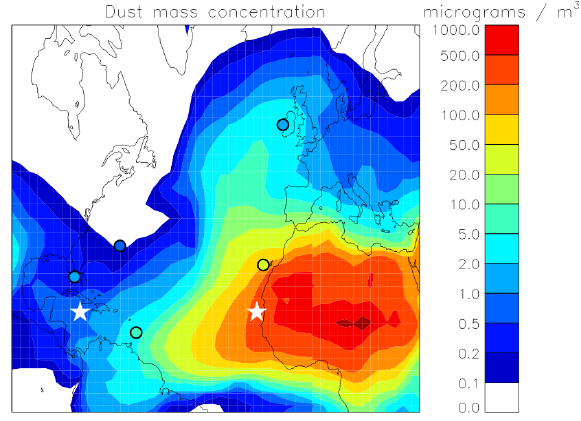
Fig. 4 Three-month mean (January-March) surface dust mass concentrations from Fig. 4. Three-month mean (January–March) surface dust mass con- the region of interest from GLOMAP-bin, overlaid with equivalent in-situ observations centrations from the region of interest from GLOMAP-bin, over- from the University of Miami aerosol network (coloured circles). Stars highlight laid with equivalent in-situ observations from the University of Mi- locations referred to in Fig. 5 and in the text. ami aerosol network (coloured circles). Stars highlight locations referred to in Fig. 5 and in the